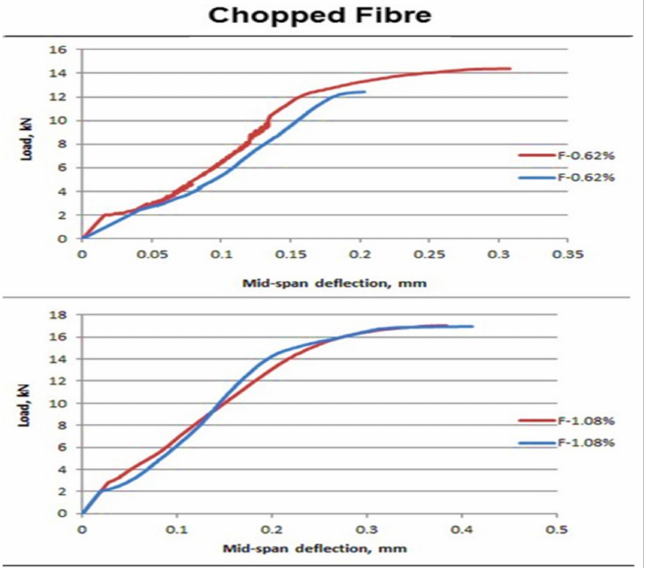
Figure 18. Mid-span load-deflection of short fibres with different fibre dosages.